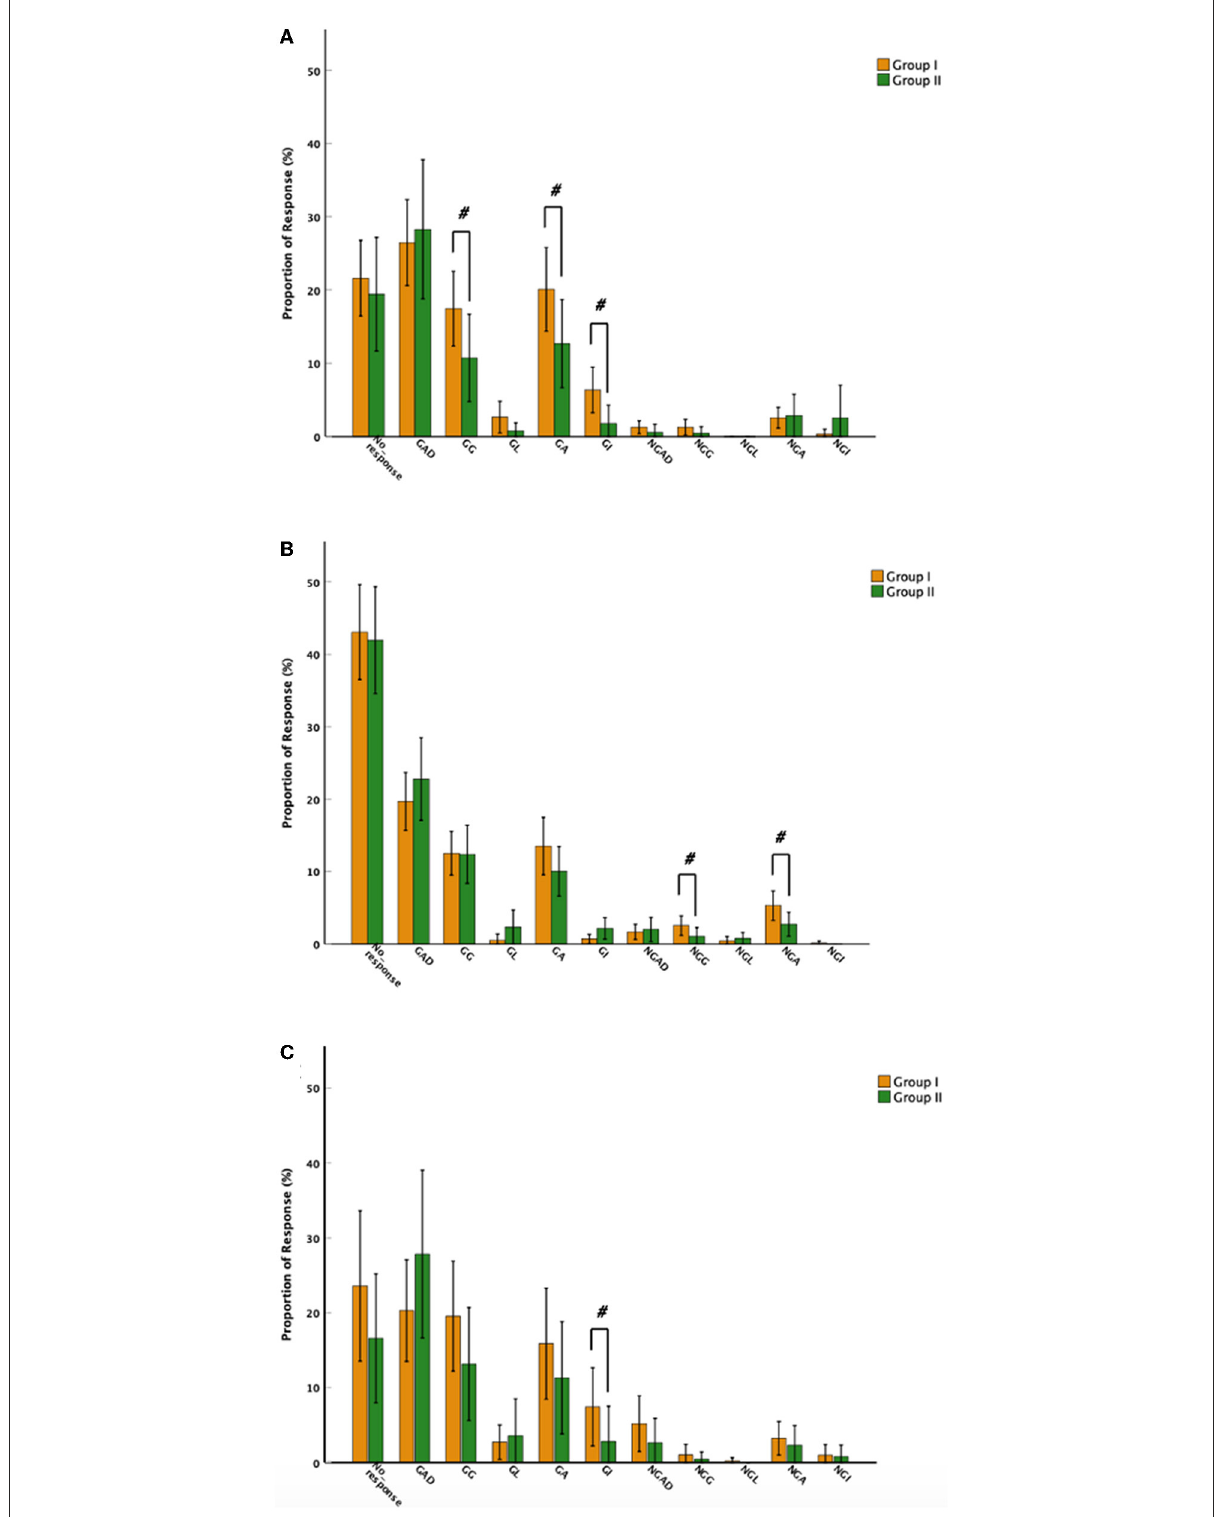
FIGURE4 Mean proportion of toddler response types to caregivers’ gestures among groups I and II. (A) Toddlers with autism spectrum disorder (ASD) responses to synchronized gestures in play activities; (B) ASD responses to unsynchronized gestures in play activities. (C) Typically